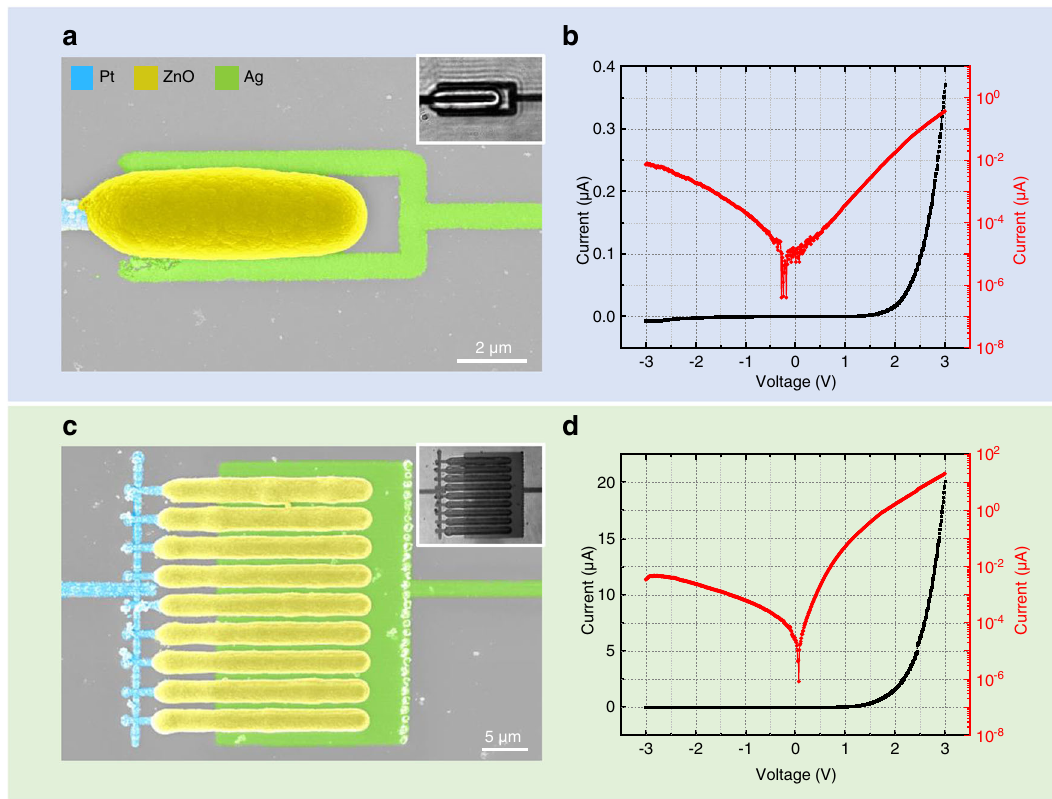
Fig. 3 | Laser-printed Pt – ZnO – Ag diodes. a Scanning-electron micrograph of a single diode composed of Pt and Ag wires (see coloration) and a ZnO bar in between. Inset: optical transmission micrograph of the same structure. b Corresponding measured current-voltage characteristics on a linear (left, black)